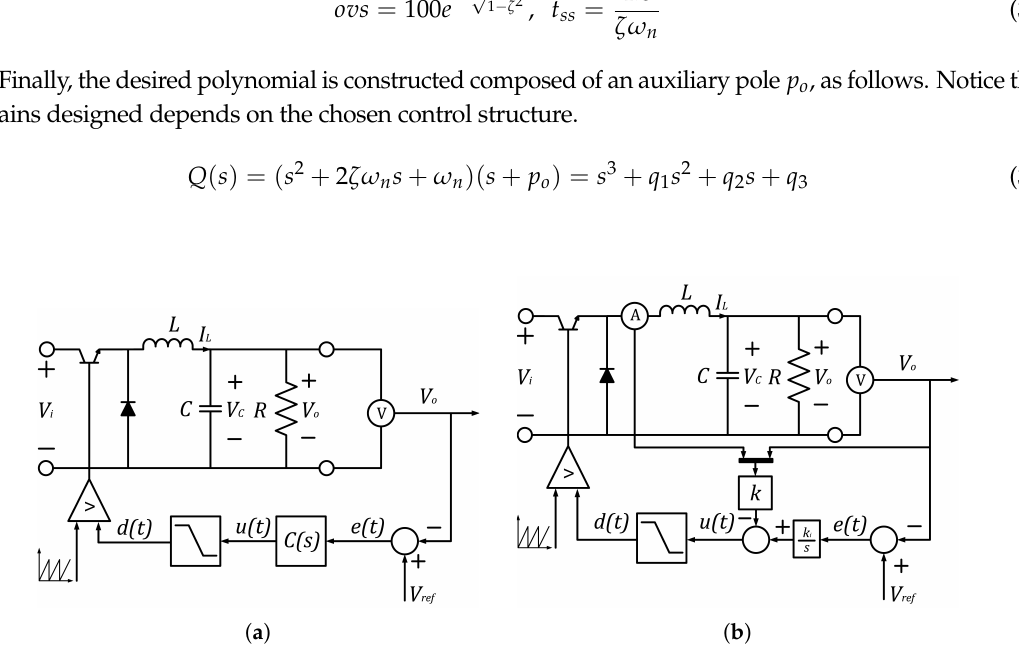
Figure 8. ( a ) Buck feeder using output feedback. ( b ) Buck feeder using state feedback with robust